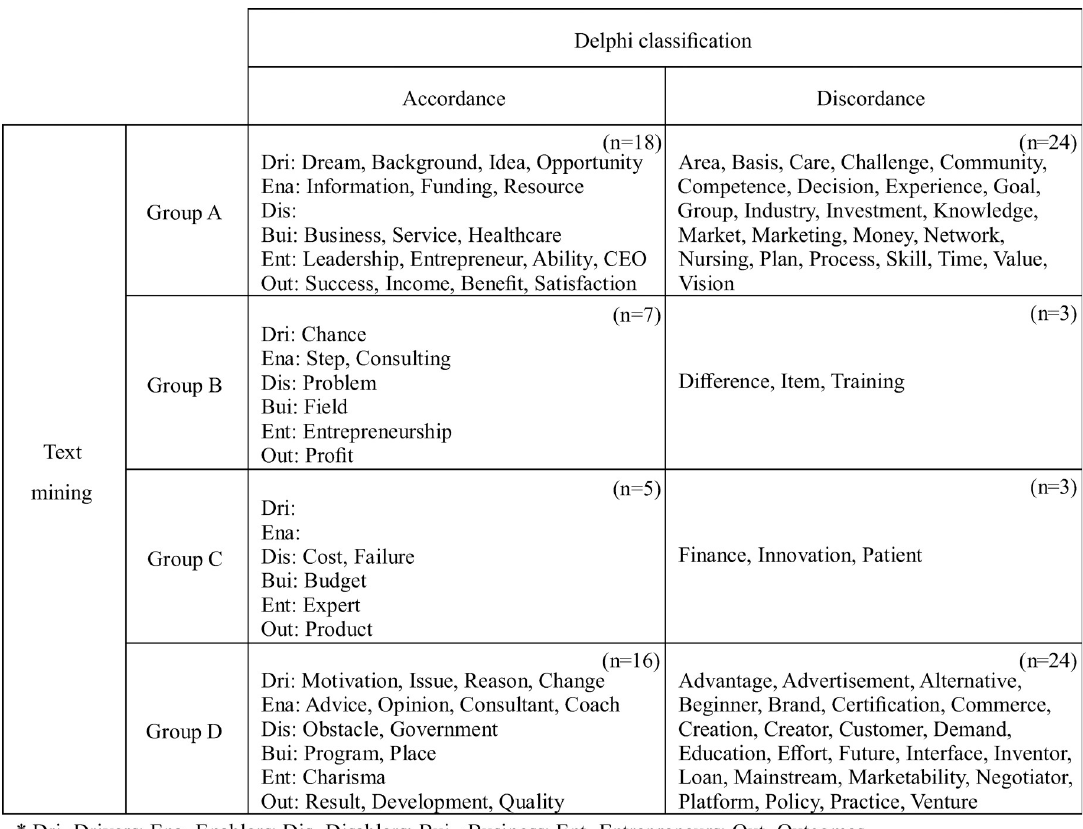
Fig 5. Comparison of text mining and Delphi